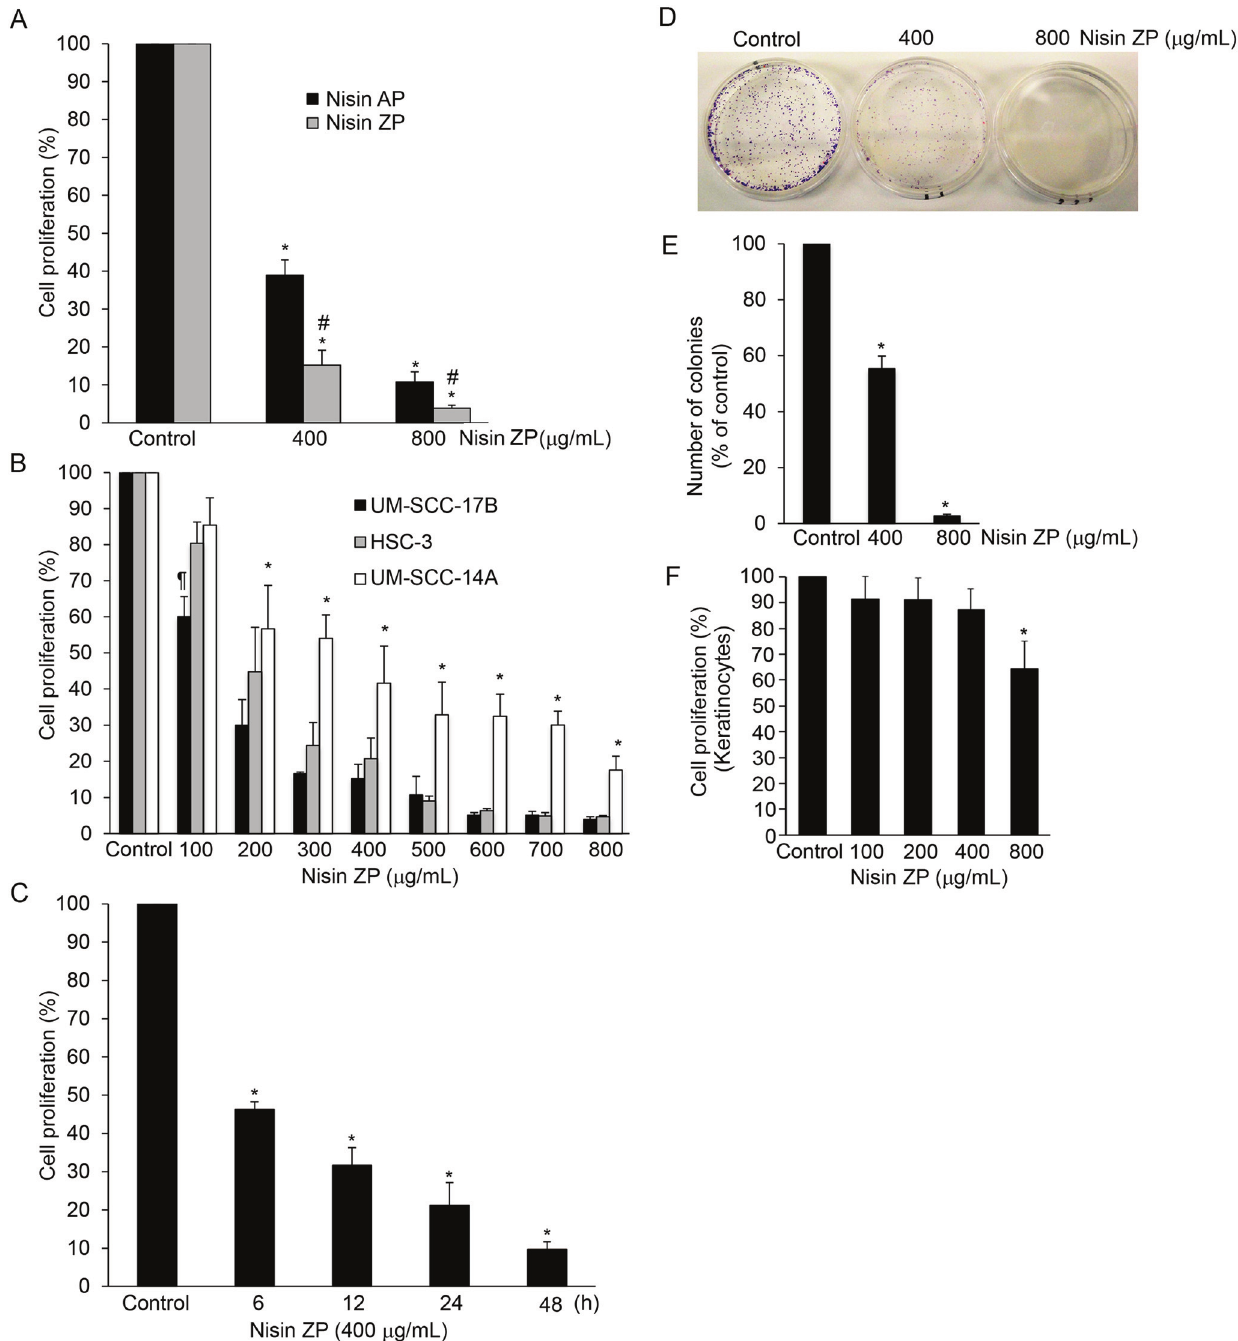
Fig 3. Nisin ZP and nisin AP significantly reduce HNSCC cell proliferation time- and dose-dependently and clonogenic capacity. A . Graphs showing changes in cell proliferation in UM-SCC-17B cells treated with control media or media containing nisin AP or ZP (400 or 800 μ g/mL) for 48 h. Comparisons between groups relative to controls were analyzed by ANOVA with the level of significance set at * p < 0.05. # Comparison between nisin AP and nisin ZP * p (cid:3) 0.05. B . Graphs showing changes in cell proliferation in HNSCC cells (UM-SCC-17B, HSC-3 and UM-SCC-14A) treated with control media or media containing increasing doses of nisin ZP (100 to 800 μ g/mL) for 48 h. Comparisons between groups relative to controls were analyzed by ANOVA with the level of significance set at * p < 0.05. ¶Comparison between the 100 μ g/ml group relative to the control for UM-SCC-17B cells * p μ 0.05. C . Graphs showing changes in cell proliferation in UM-SCC-17B cells treated with control media or media containing nisin ZP (400 μ g/mL) for 6, 12, 24 and 48 h. Comparisons between groups relative to controls were analyzed by ANOVA with the level of significance set at * p < 0.05. D , The images are of UM-SCC-17B cells treated for 48h with control media or media containing nisin ZP (400 or 800 μ g/mL) then cultured for 10 days, stained with crystal violet and imaged to evaluate